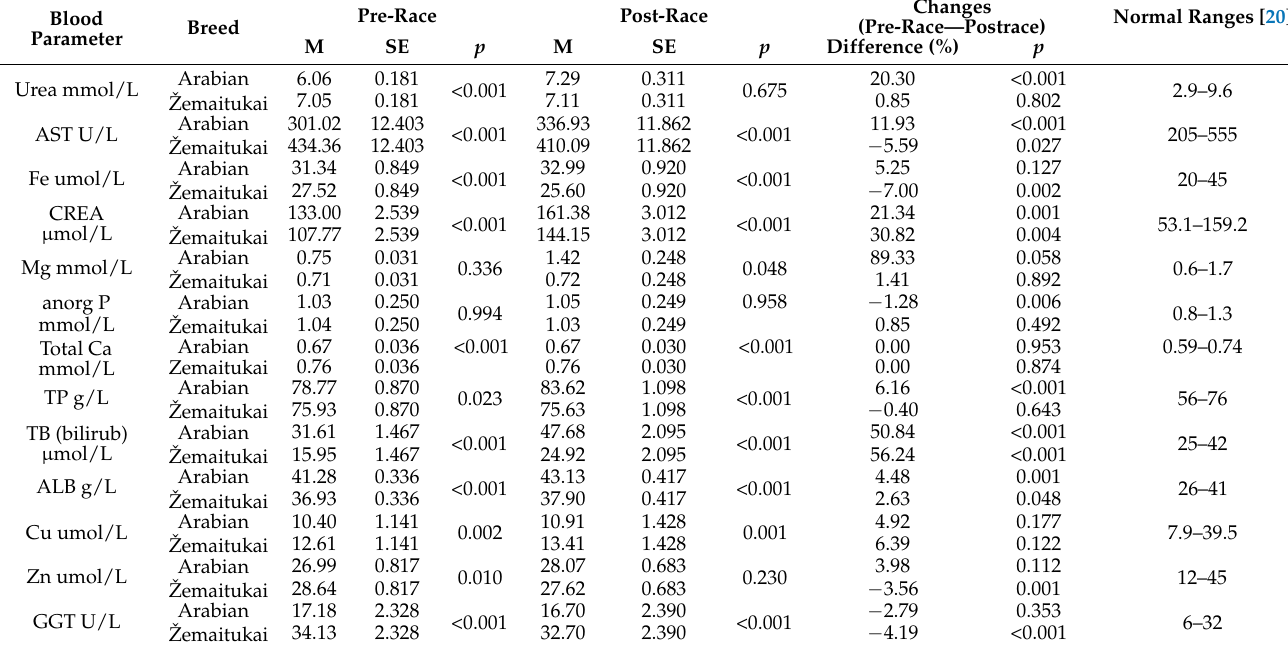
Table 1. The indices of minerals, trace elements, and biochemical parameters in the blood of the Arabian and Žemaitukai horses before and after competition.